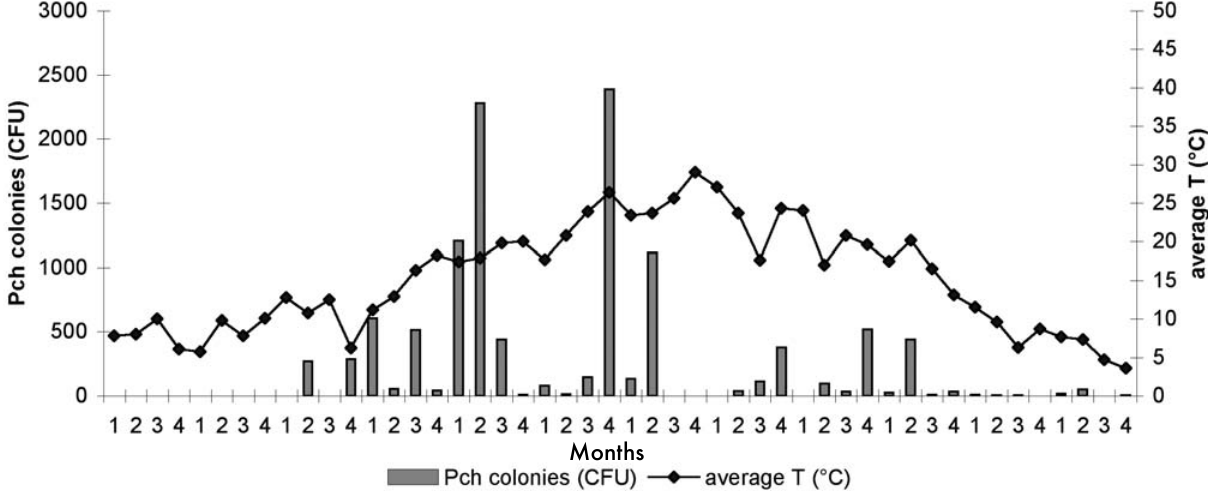
Fig. 7. (b) Number of spores of Phaeomoniella chlamydospora trapped per week and temperature, from January to December 2007. CFU= Colonies Forming Unit (number of spores able of giving origin to new